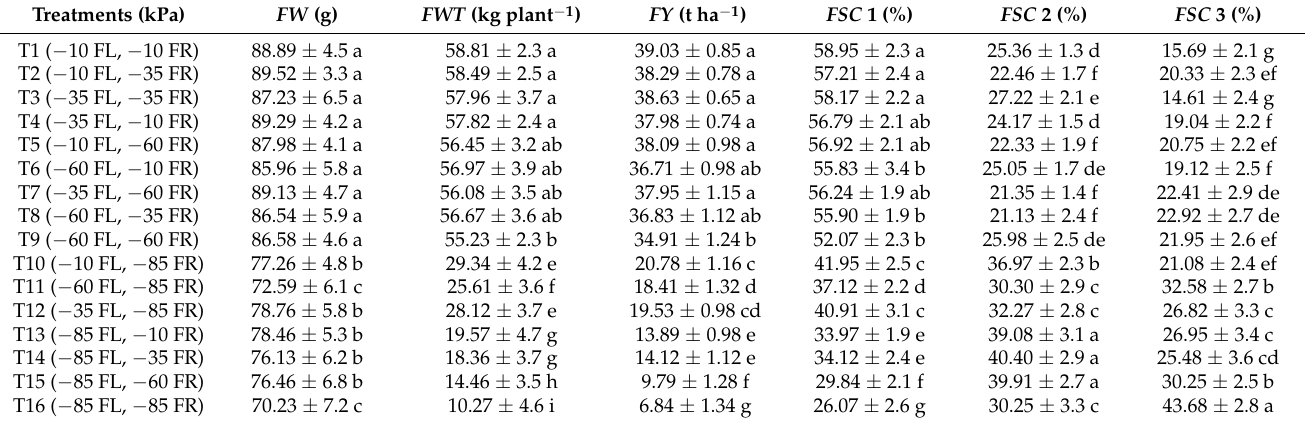
Table 4. Average fruit weight ( FW ), fruit weight per tree ( FWT ), fruit yield ( FY ), and fruit size code percentages ( FSC 1, 2, and